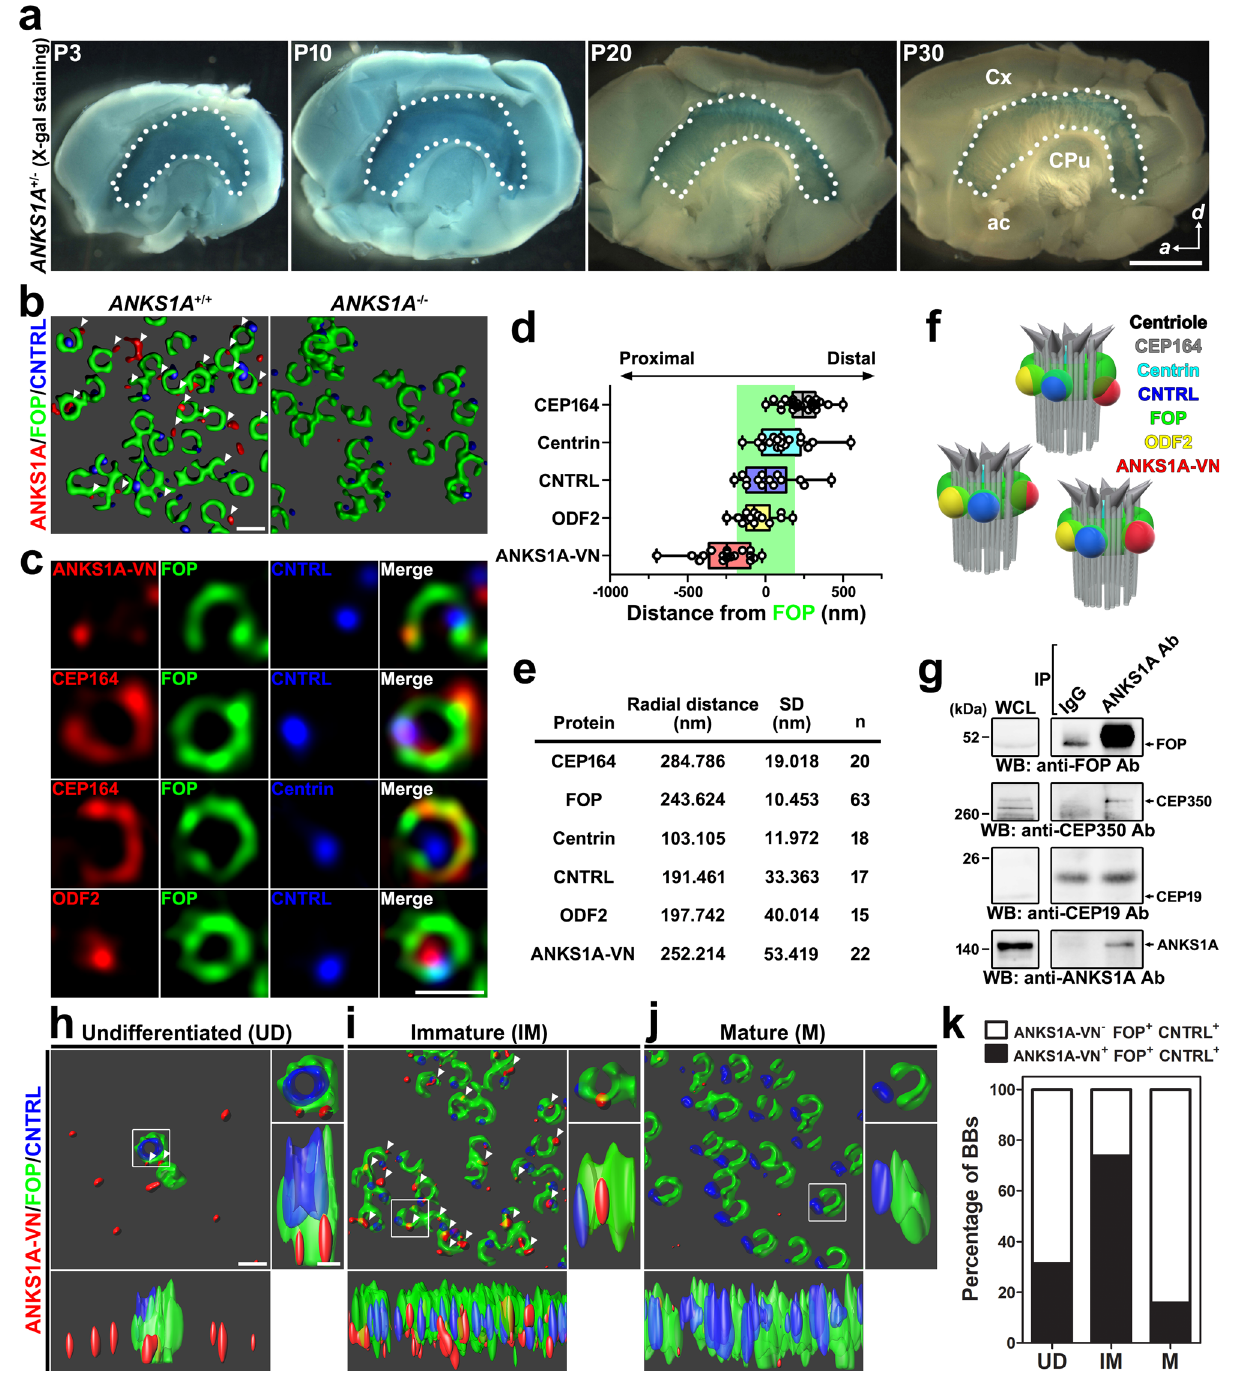
Fig. 1 Speci fi c localization of ANKS1A to FOP-positive SDAs. a LWs (marked by dotted lines) with other forebrain tissues were subjected to X-gal staining. Scale bar, 500 μ m. Cx cortex, CPu caudate putamen, ac anterior commissure. b The LWs were co-stained with ANKS1A, FOP, and CNTRL antibodies. The 3D SIM images were analyzed by the Imaris software. c 3DSIM micrographs of representative BBs. ANKS1A-VN was injected into the LV at E16.5 and subjected to in utero electroporation. The LWs at P4 were then co-stained for FOP and various BB markers with antibodies. Scale bar for b , c , 500 nm. d A median line and upper and lower quartile are presented in box and whisker plot of the axial distances of BB proteins from immature E1 cells. CEP164, n = 24; Centrin, n = 19; CNTRL, n = 14; ODF2, n = 15; ANKS1A-VN, n = 18. A green-shaded box marks a FOP-stained region brighter than 30% of the maximum intensity. e Table showing the radial distances of BB proteins from immature cells. The center of the FOP-positive ring image was used as a reference for the radial distances of BB proteins; n indicates the number of BBs used for statistical analysis. SD standard deviation. f Cartoon depiction of the BB proteins shown in d , e . g Whole-cell lysates (WCL) were prepared from six LWs at P4 and then the protein complexes were precipitated with the C-terminal speci fi c antibody to detect the ANKS1A-associated proteins. h – j 3DSIM micrographs of BBs in E1 cells representing three different developmental stages. White arrowheads mark ANKS1A-VN present in FOP-stained SDAs. Scale bar for h – j , 500 nm. k Data shown in h – j were quanti fi ed with the total number of the double-positive FOP + CNTRL + BBs set to 100%. Then the percentage of triple-positive ANKS1A + FOP + CNTRL + BBs was calculated. Undifferentiated (UD), n = 67; immature (IM), n = 195; mature (M), n = 227 where n indicates the number of BBs analyzed. NATURE COMMUNICATIONS| (2021) 12:612 |https://doi.org/10.1038/s41467-021-20902-4|www.nature.com/naturecommunications